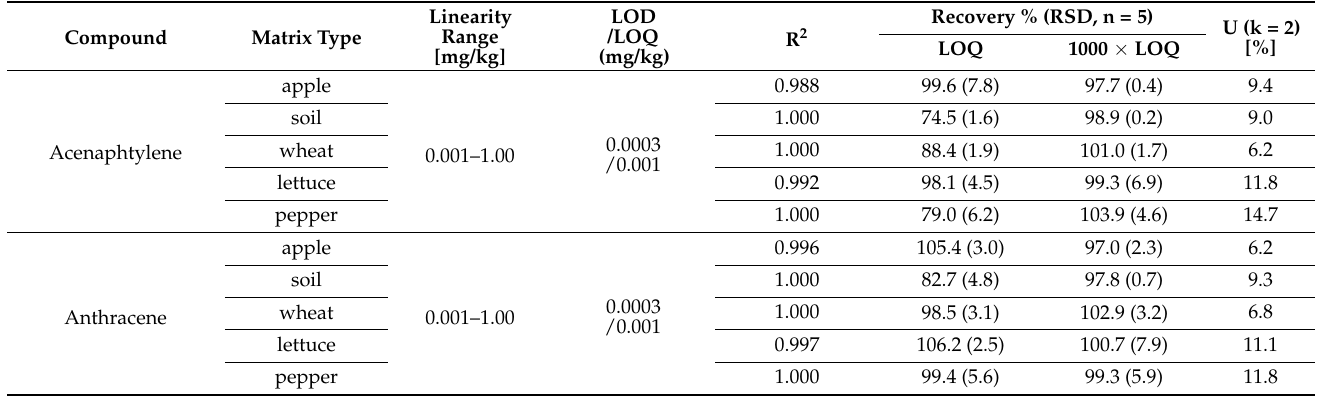
Table 4. Validation parameters for PAH determinations (linearity range, calibration curve and coefficient of determination, recovery, standard deviation from recoveries (RSD), measurement uncertainty